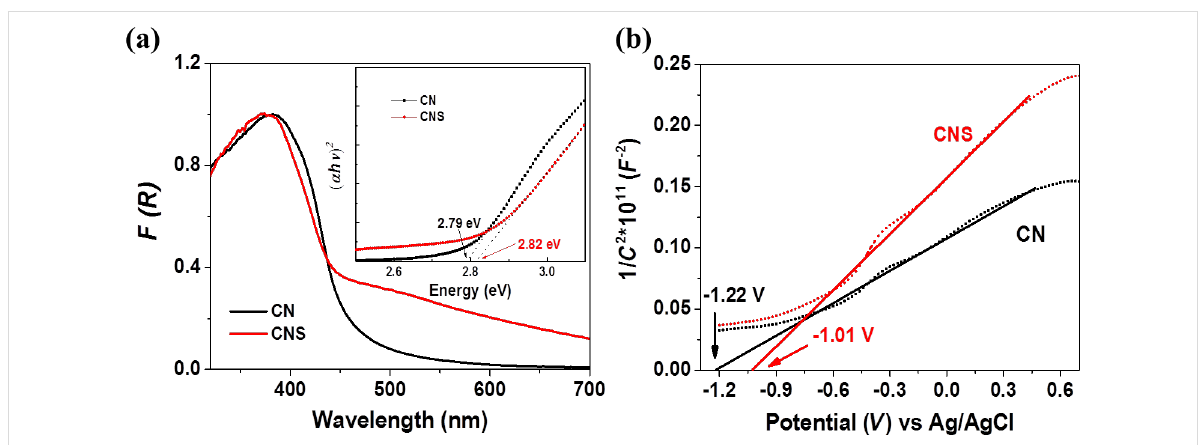
Figure 2: (a) Optical absorption spectra of CN and CNS. Inset shows the Tauc plots for bandgap determination, (b) Mott–Schottky plots for CN and